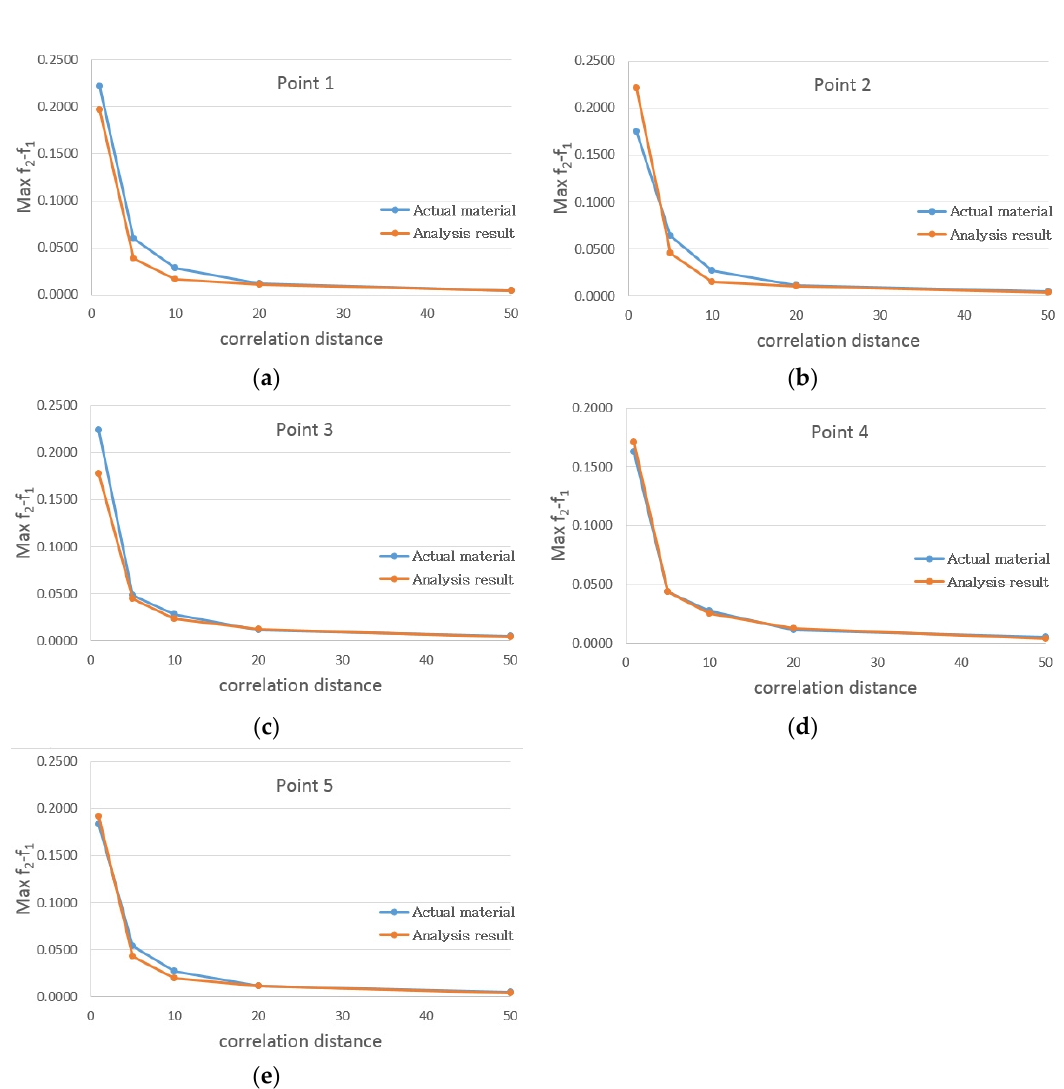
Figure 13. Comparison of d for simulated (imitated) material and inversely analyzed d: ( a ) Observation point 1; ( b ) Observation point 2; ( c ) Observation point 3; ( d ) Observation point 4; ( e ) Observation point 5.